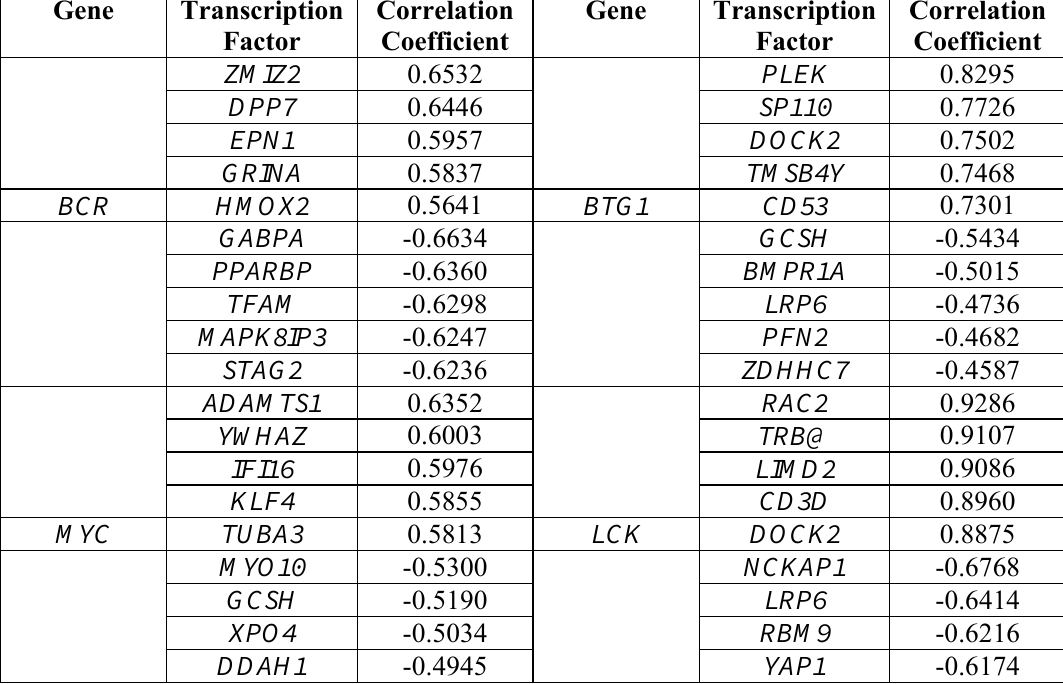
Table 4: The list of transcription factors highly correlated to leukemia genes